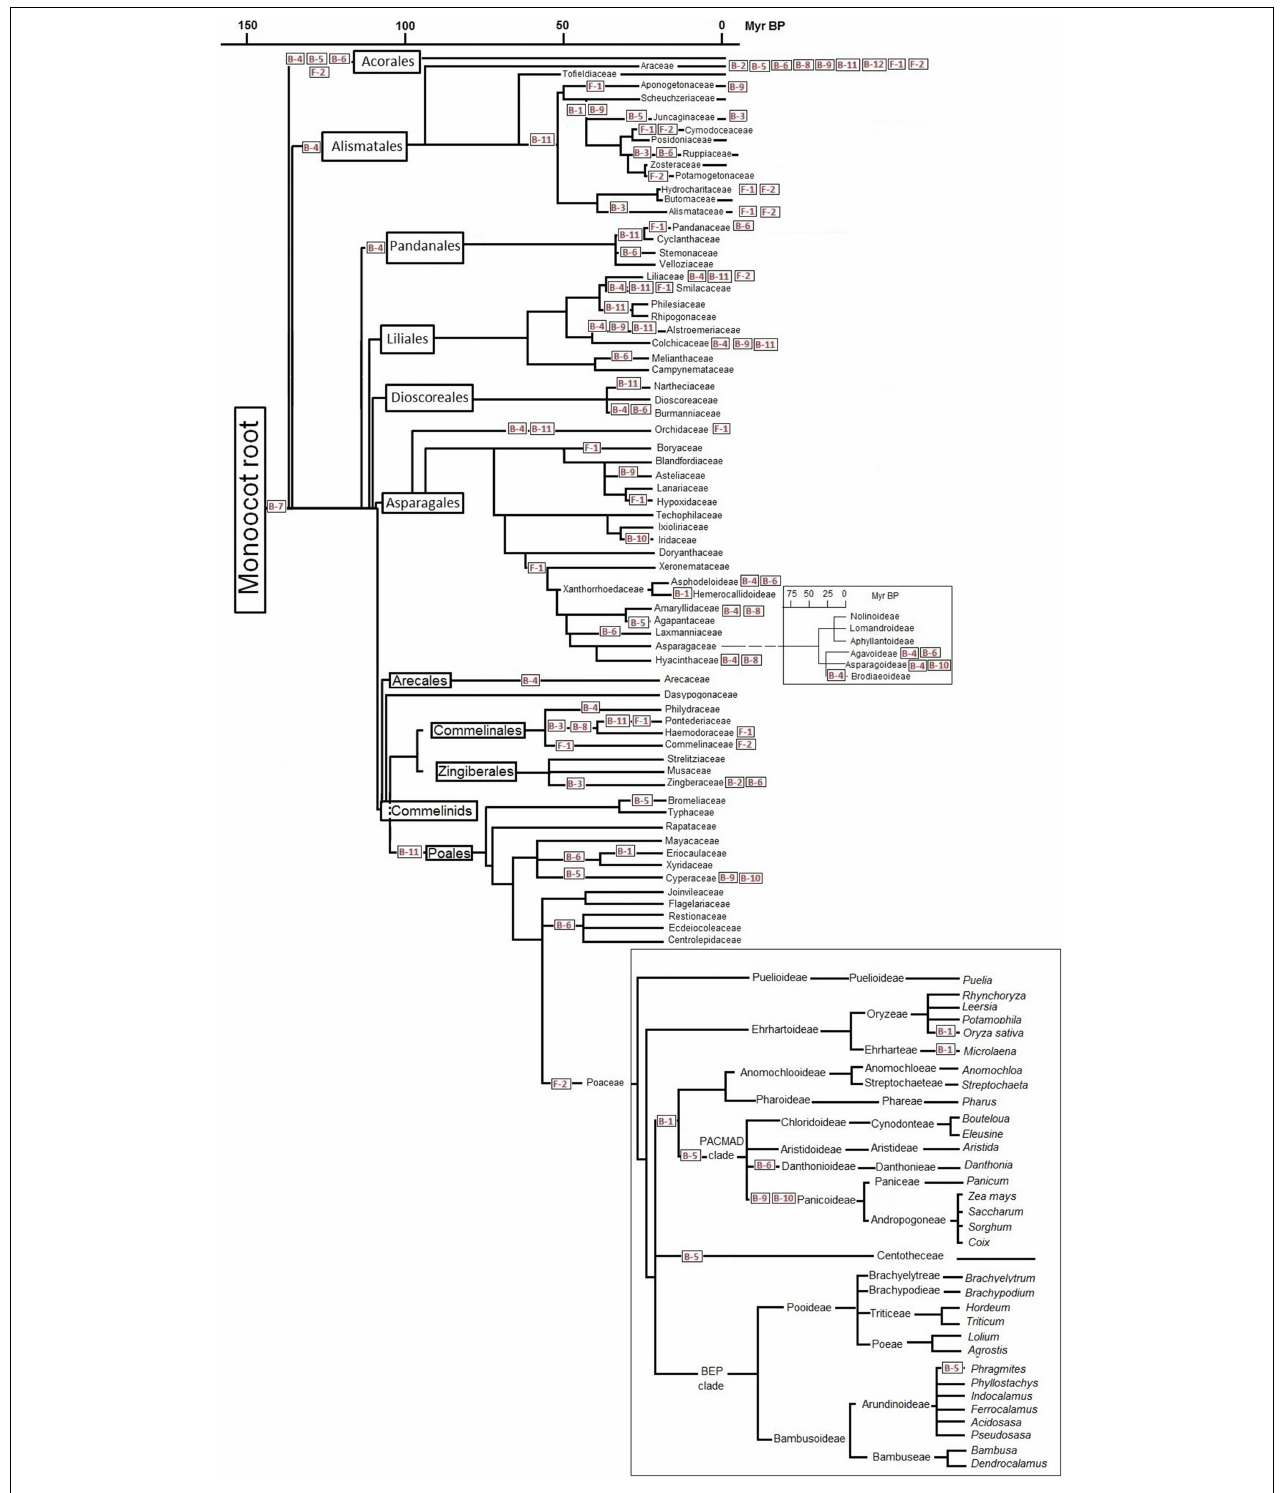
squares) are C-to-T corrected in all species tested that belong to the order, family or genus that follow it at right in the phylogenetic tree. Editing sites placed at far right indicate that some but not all species of the family or genus affected have a C-to-T back mutation at that